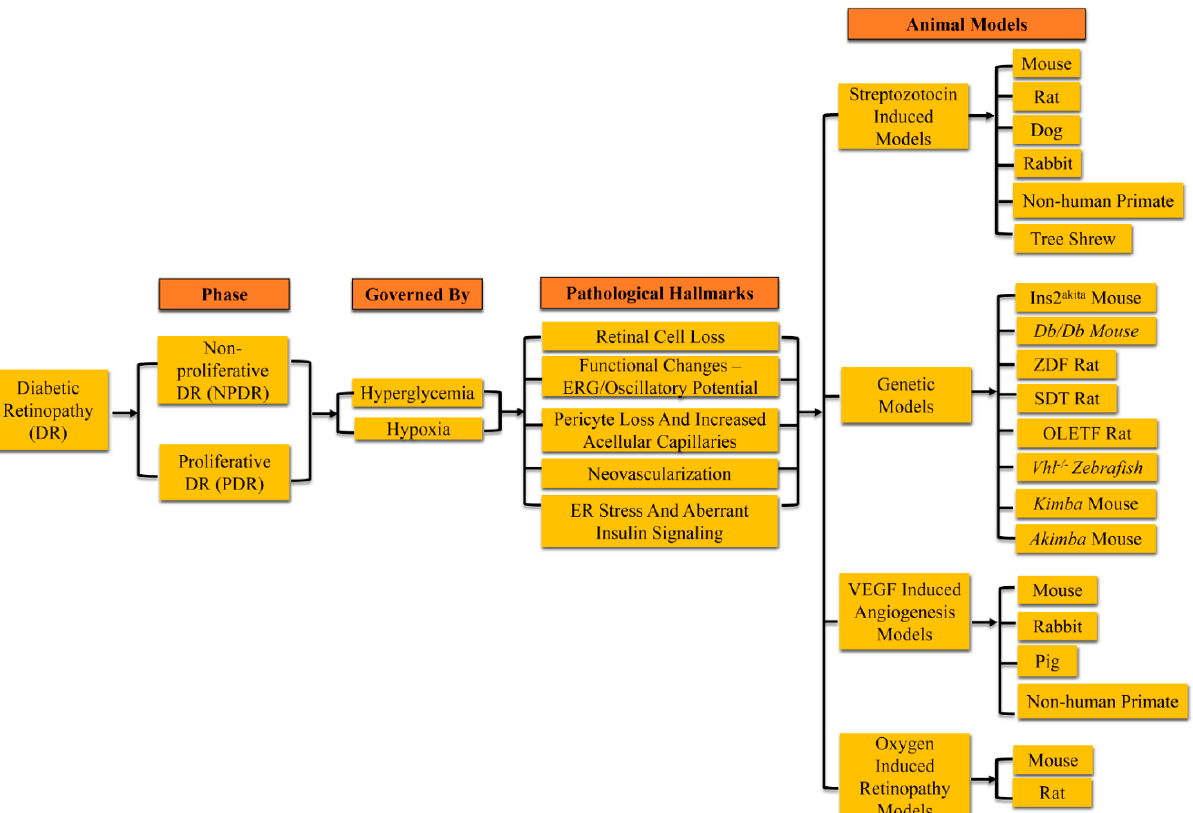
Figure 2. Animal models of diabetic retinopathy were developed to mimic non-proliferative and proliferative stages of diabetic retinopathy (DR). These models were created by inducing hyperglycemia or hypoxic conditions. Observed retinal pathophysiological features present neuronal function and cell loss in addition to vascular dysfunction. These models include rodents, cats, dogs, pigs, non-human primates, and zebra fish. They are genetically modified and/or pharmacologically-induced animal models of DR. (ERG-Electroretinogram; ER- Endoplasmic reticulum; ZDF- Zucker diabetic fatty; OLETF- Otsuka Long-Evans Tokushima fatty; vhl- von Hippel-Lindau).